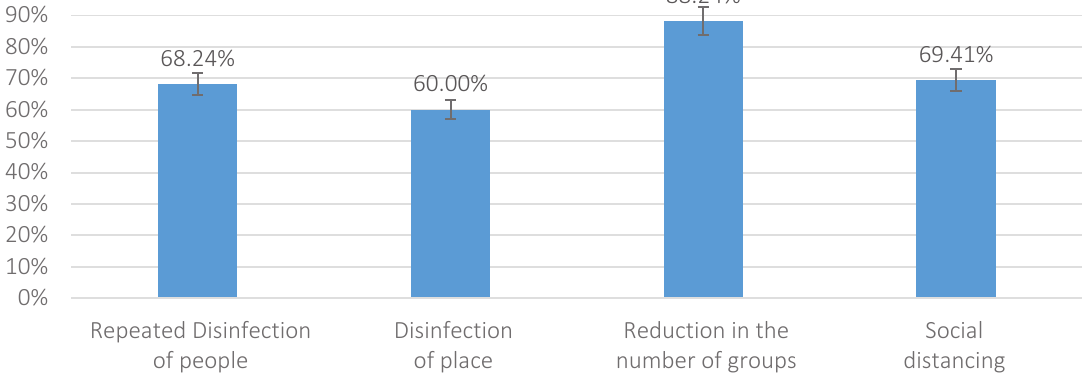
Figure 7. Post-Covid-19 travel changes